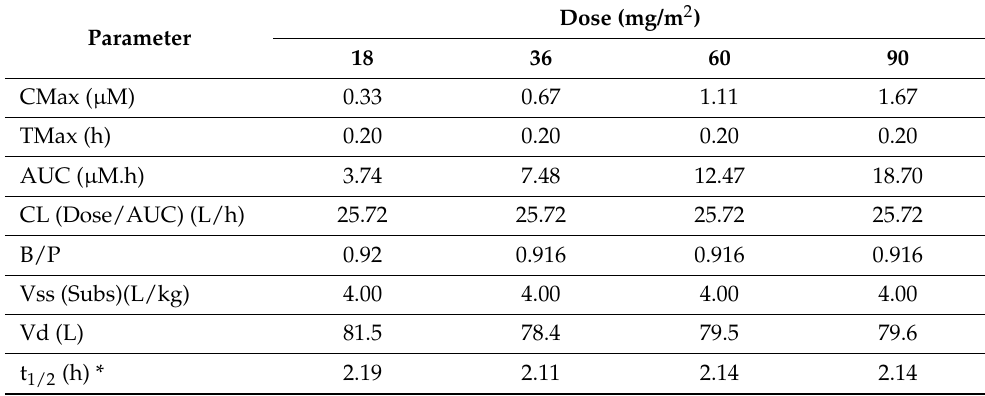
Figure 5. EGFR-wt binding site interactions. Carbon atoms are represented in grey, sulfur in yellow, oxygen in red, and nitrogen in blue. ( A ) Gefitinib on EGFR wt (PDB: 2ITY)—hydrogen bond interaction with Met793 (adenine region). ( B ) Interaction of LASSBio-1586 on EGFR wt (PDB: 2ITY). ( C ) Interaction of LASSBio-1920 on EGFR wt (PDB: 2ITY). Figures generated from the PyMol program. Table 3. LASSBio-1920 pharmacokinetic profiles in human simulation